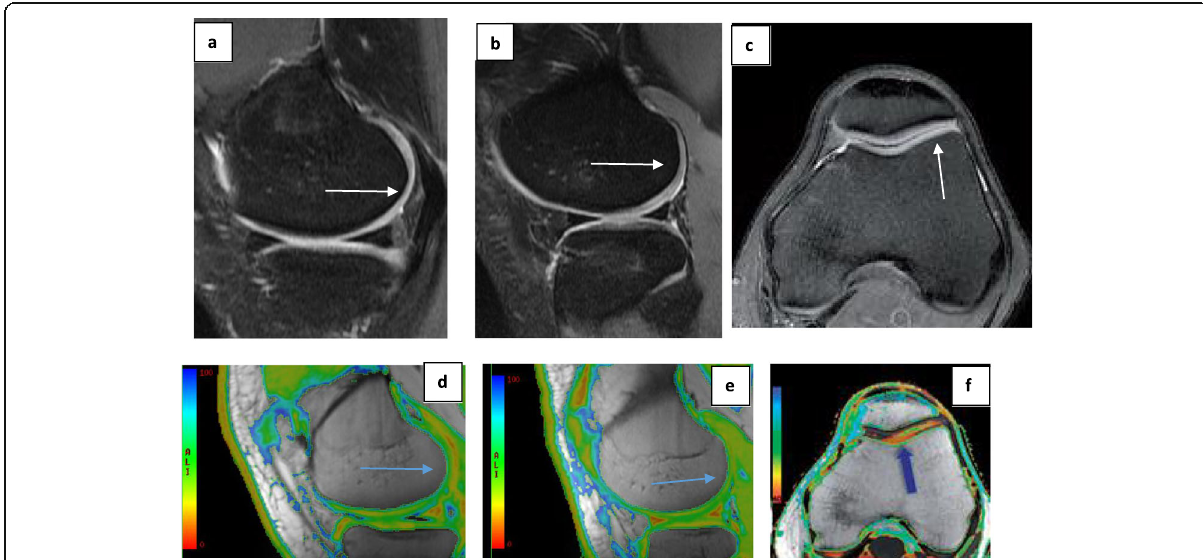
Fig. 1 Bright hyper-intense signal of cartilage at medial ( a ) and lateral ( b ) tibio-femoral condyles and patellofemoral ( c ) with uniform cartilage thickness (arrows). d – f Normal color coded values of cartilage (superficial and deep zones normal (red, yellow, or green)) at both medial and